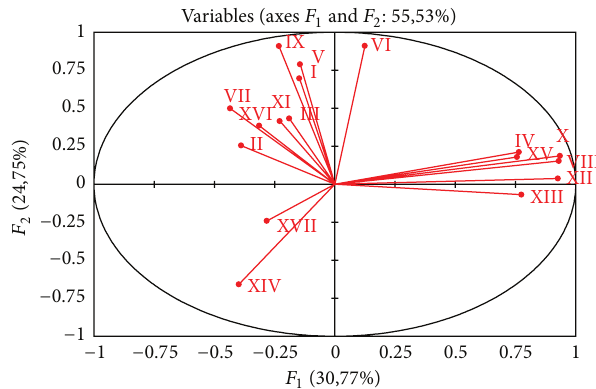
Figure 1: PCA: projection of the variables on the factor plane.